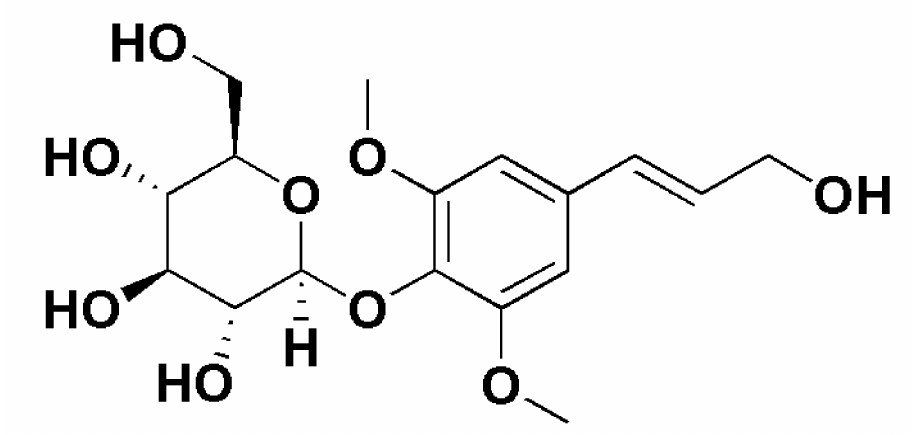
Figure 4. Chemical structure of